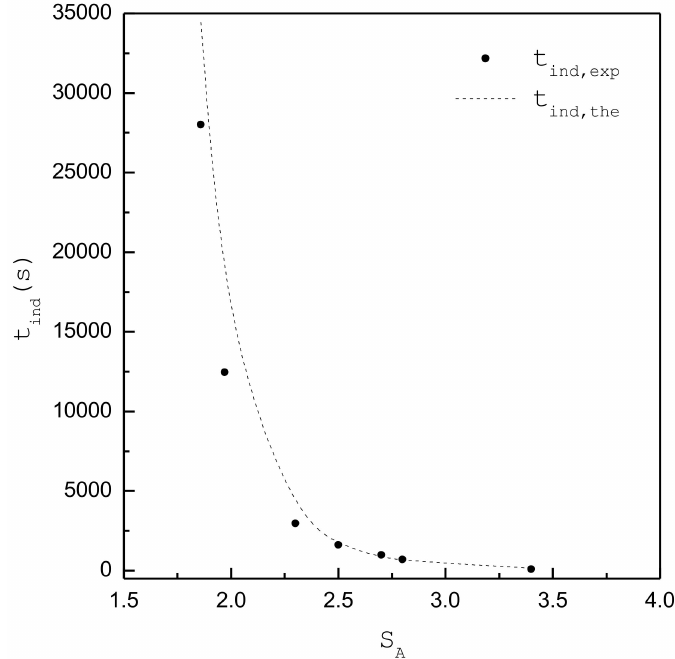
Figure 2. Comparison of t ind,the and t ind,exp for various S A , where t ind,the is calculated from Equation (22) using the optimal values of k A , k B , k dA0 and k dB0 . The dashed line represents the calculated t ind,the while the solid circle represents the experimental t ind,exp